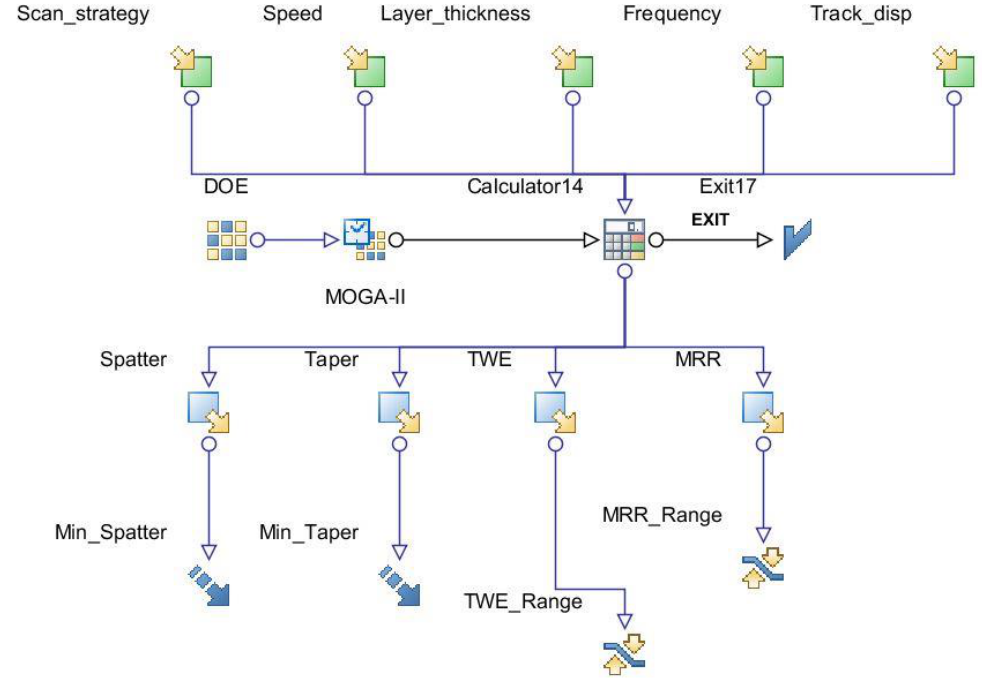
Figure 13. Optimization model workflow in ModeFRONTIER.